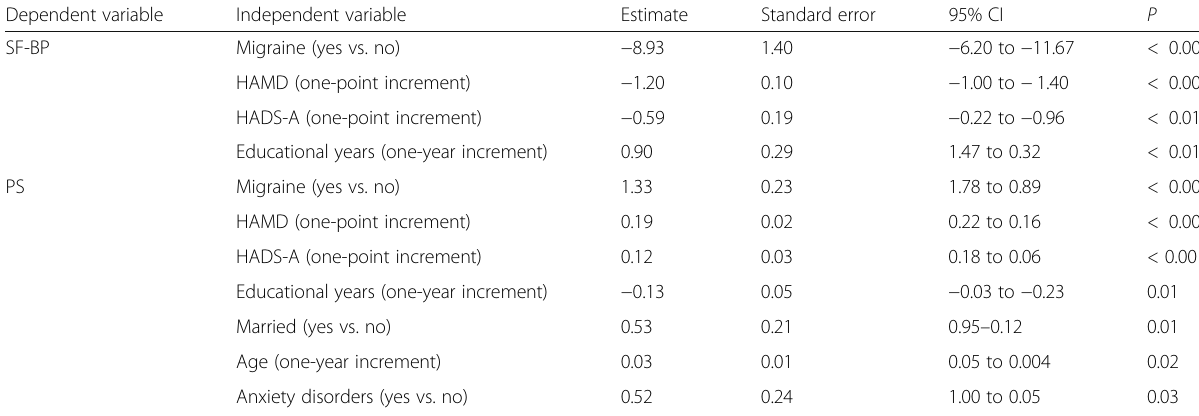
Table 4 Independent variables associated with pain indices a Dependent variable Independent variable